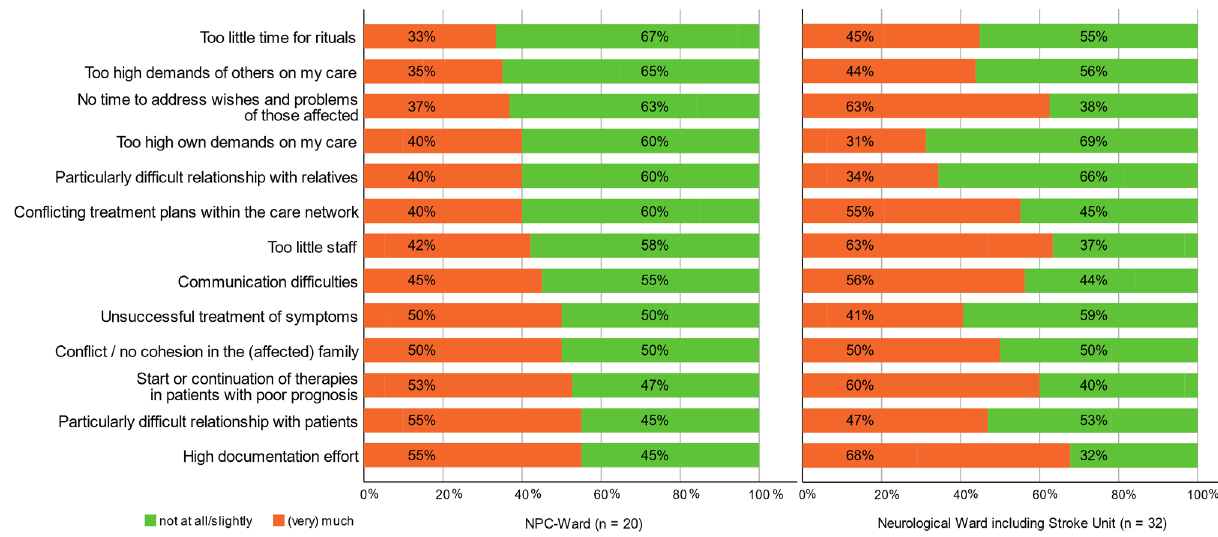
Figure 1. Factors perceived as especially burdening (= over one-third of the team answered with much or very much burdening) on the NPC ward and the neurological ward, including the stroke unit. The importance of burden factors was dichotomized as “not at all/slightly” and “(very) much”. burdened with “ Too many patients” ( p < 0.0001, significance level after Bonferroni